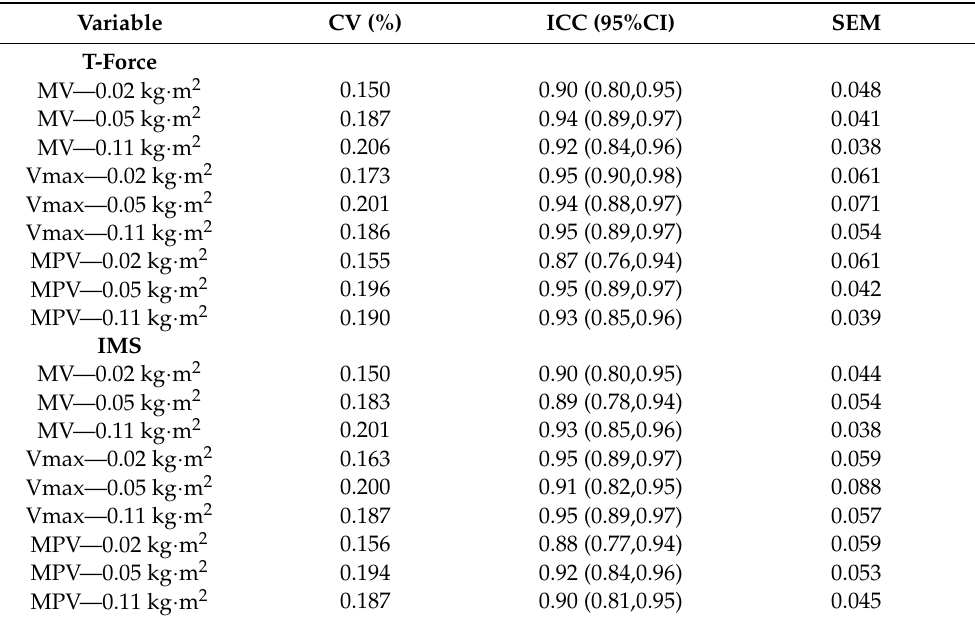
Table 3. Coefficient of variation (CV), Intraclass correlation (ICC) with 95% confidence interval (min, max), and standard error of measurement (SEM) values for three loads (0.02 kg · m 2 , 0.05 kg · m 2 , velocity measured by the T-Force and